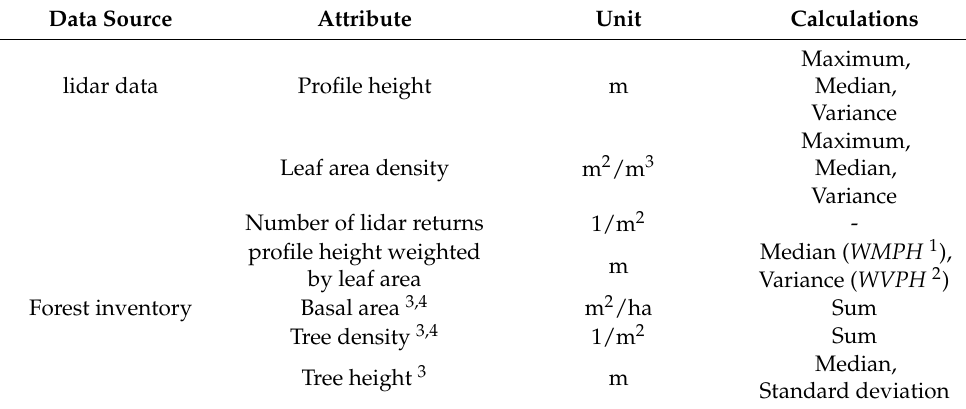
Table 1. List of attributes used for the correlations with R 2 (from the comparison of the estimated stem diameter distribution with field data). Columns denote the data used, a description of the attribute, its unit and the different statistical calculations